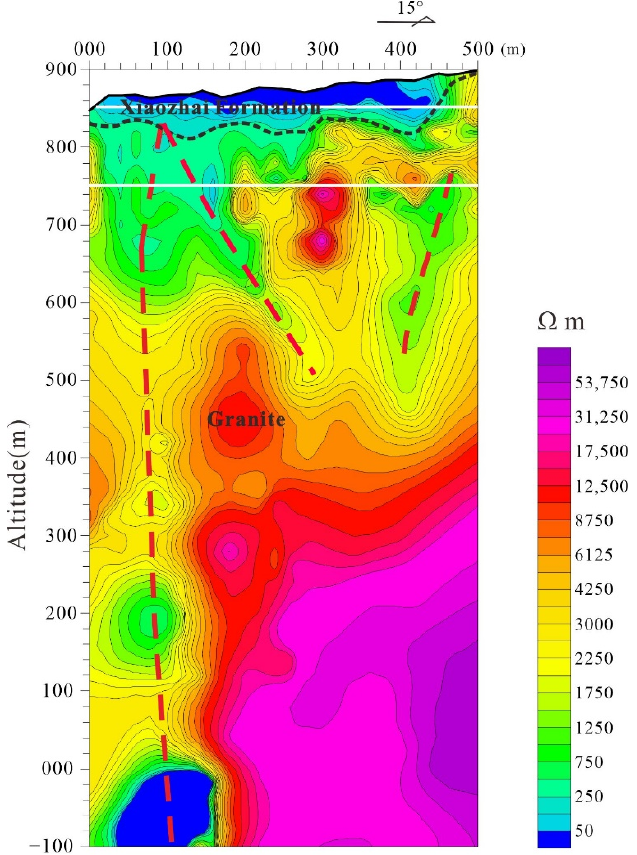
Figure 7. EH4 sounding image of Line 5 in the Xinping section of the Jianbeigou gold mine. The dashed line in the profile is the inferred geological boundary between the strata and the granite. The thick dashed red lines are the presumed mineralized zone. The white lines are the location of the exploration adit at 750 m and 850 m.